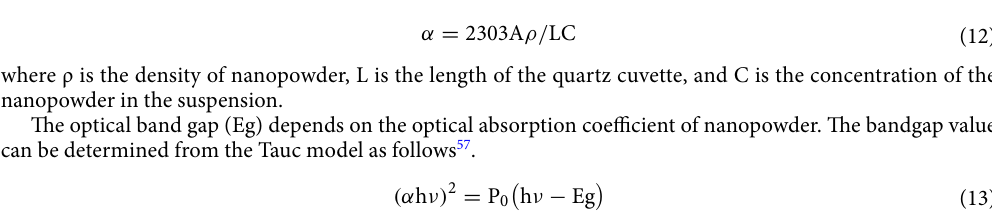
Figure 5. ( A ) Optical absorbance of prepared samples and ( B – E ) Plots of (αhν) 2 versus hν to determine E g